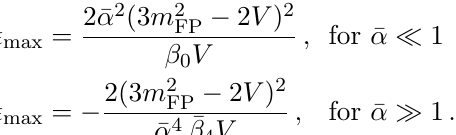
Figure 1 . The upper limit on (cid:15) is shown as a function of m 2 values of (cid:22) (cid:11) . We chose the values (cid:22) (cid:11) = 0 : 6, 0 : 8, 2, 10, where the lightest color corresponds to the largest value of (cid:22) (cid:11)